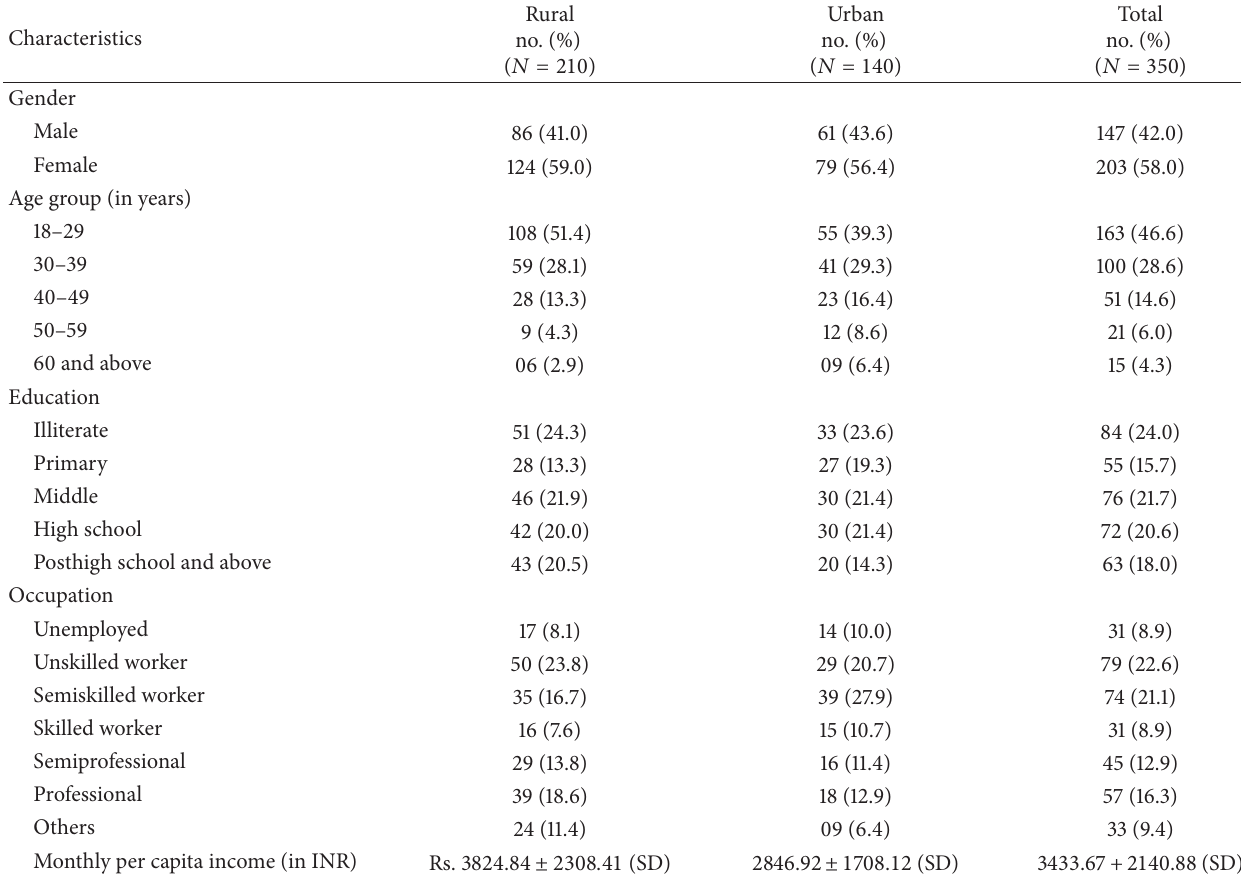
Table 1: Demographic characteristics of study